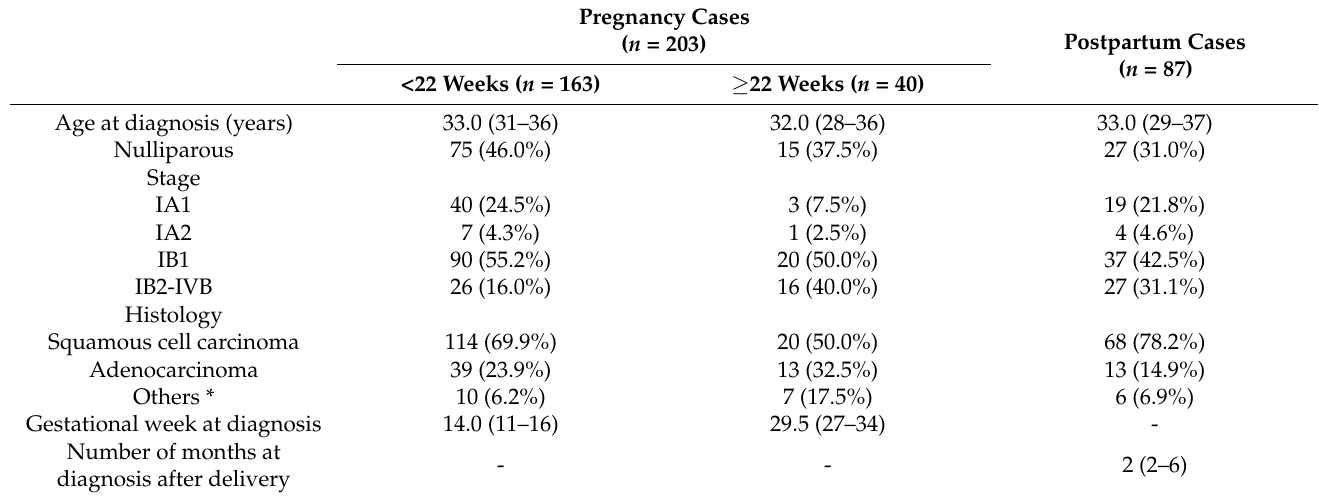
Table 1. Patient